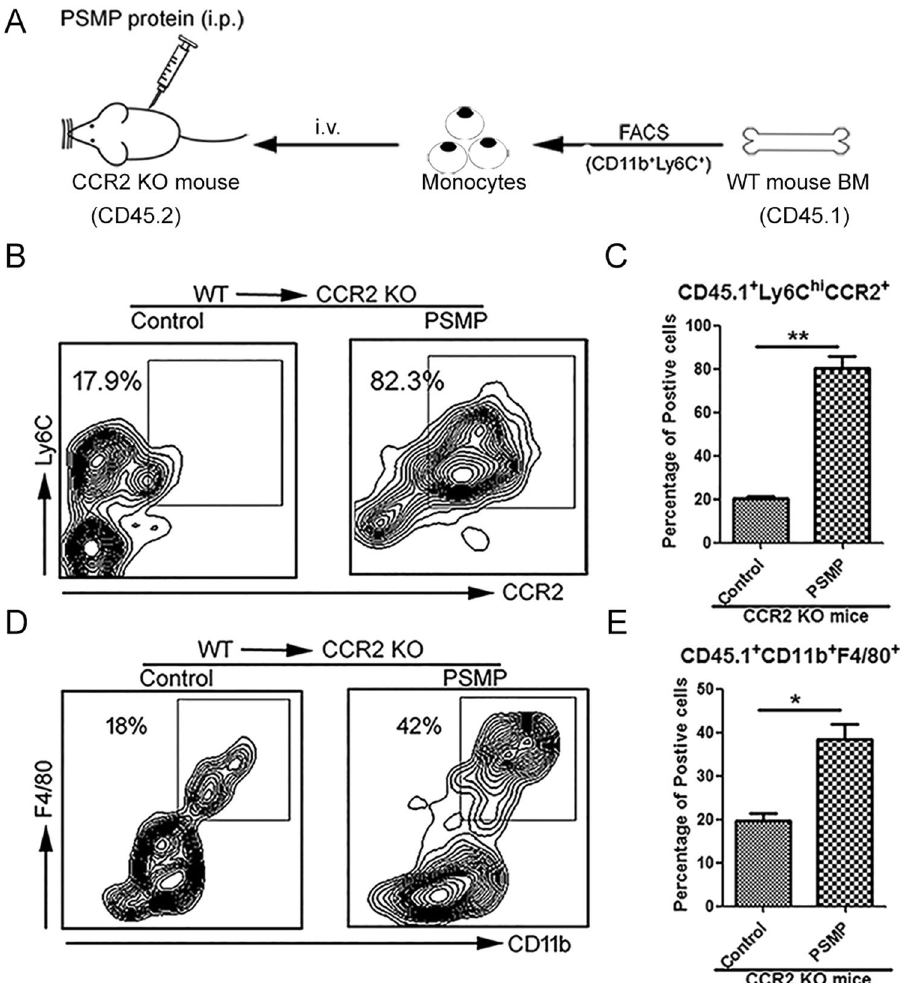
Figure 2. PSMP protein could specifically chemo-attracted the CCR2 + Ly6C hi monocytes into the abdominal cavity with CCR2 dependent manner. ( A ) Ly6C hi monocytes were sorted from wild type mice’s bone marrow, infused into CCR2 KO mouse (1 × 10 7 cells per mouse) by i . v . and PSMP protein was injected into the abdominal cavity at the same time. ( B ) and ( C ) Forty-eight hours after the CCR2 + Ly6C hi monocytes from wild type mouse bone marrow were intravenously introduced into the circulation of the CCR2 KO mice, and the percentages of monocytes (CCR2 + Ly6C hi ) in the abdominal cavities with and without PSMP were detected and statistically analyzed by flow cytometry. ( D ) and ( E )The percentages of macrophage (CD11b + F4/80 + ) in the abdominal cavities of the adopted transfer mice with and without PSMP were analyzed by flow cytometry. Data were representative of at least two independent experiments with four mice per group. * 0.01 < p < 0.05, ** 0.001 < p < 0.01, and *** p <